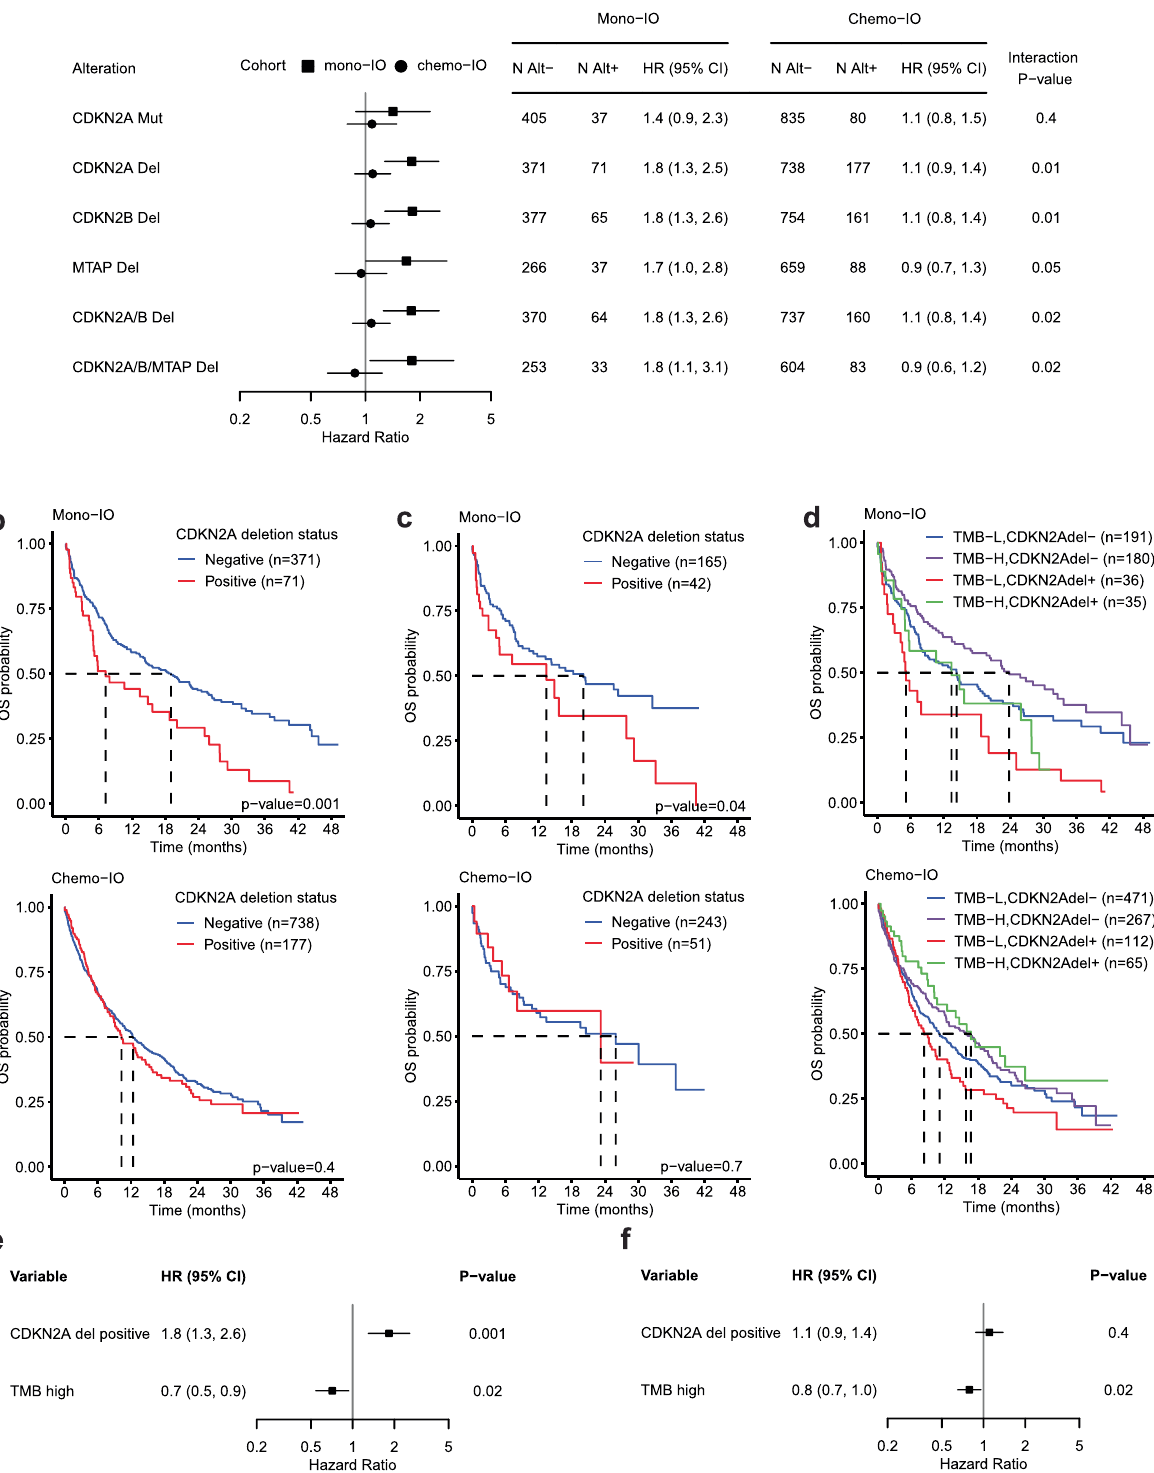
Fig. 3 Deletions at chromosome 9p21.3 predict poor response to single-agent immunotherapy. a Forest plot of hazard ratios and 95% CIs for overall survival according to speci fi c gene alterations at chromosome 9p21.3. b – d Kaplan – Meier plot of overall survival for mono-IO (top) and chemo-IO (bottom) treated patients according to CDKN2A deletion status. For c , analyses are restricted to PD-L1-positive patients. In d , overall survival is further strati fi ed by TMB status. Forest plot of hazard ratios and 95% CIs for overall survival from multivariable model for e mono-IO and f chemo-IO treated patients. TMB-high ( ≥ 10 mut/Mb), TMB-low (<10